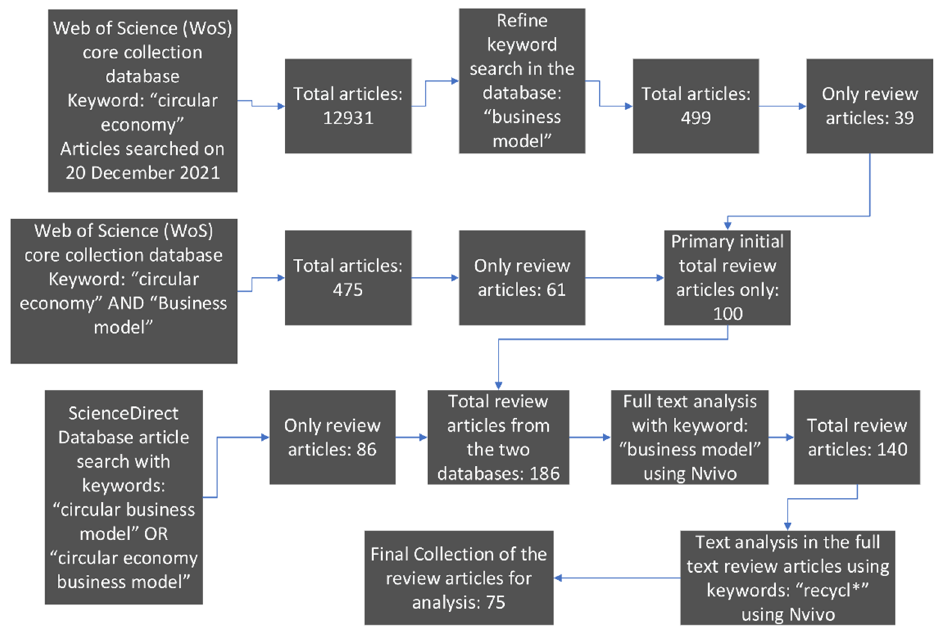
Figure 3. Data collection from WoS and ScienceDirect database.